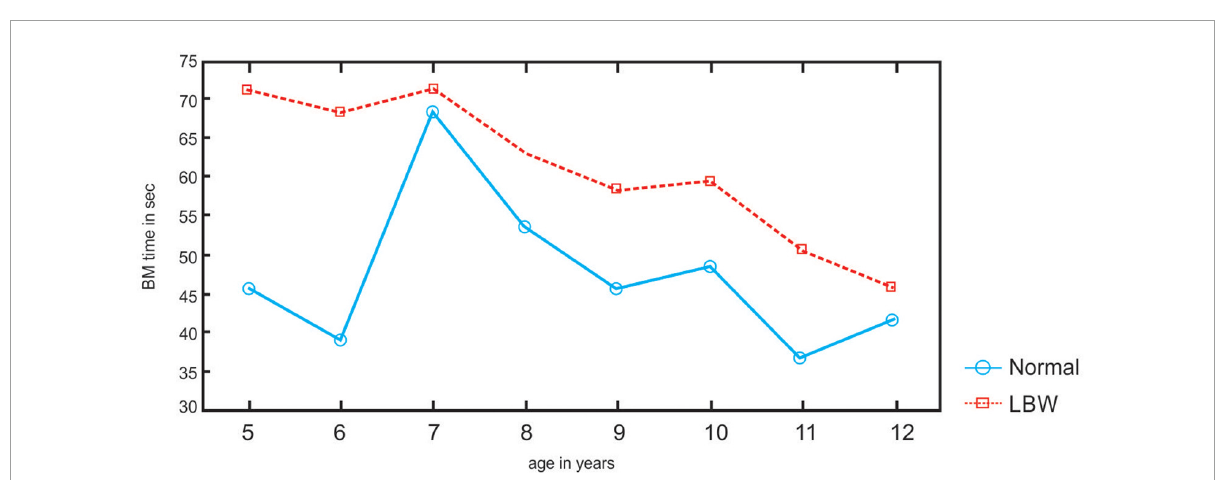
FIGURE3 Laterality index (LI) for normal birthweight (NBW) children.